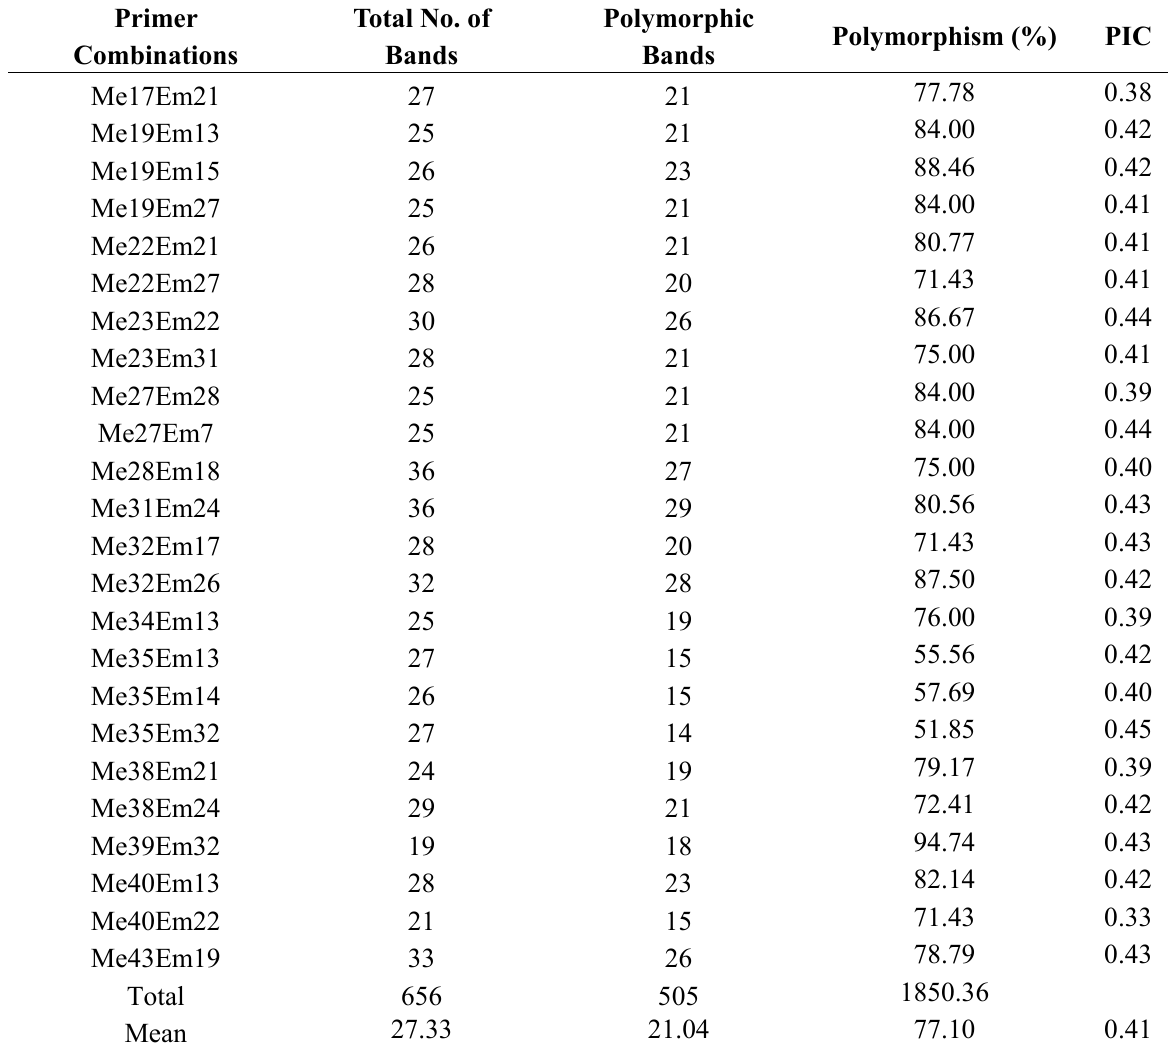
Table 3. Total number of bands, polymorphic bands, polymorphism and polymorphic information content (PIC) obtained from 24 SRAP primer